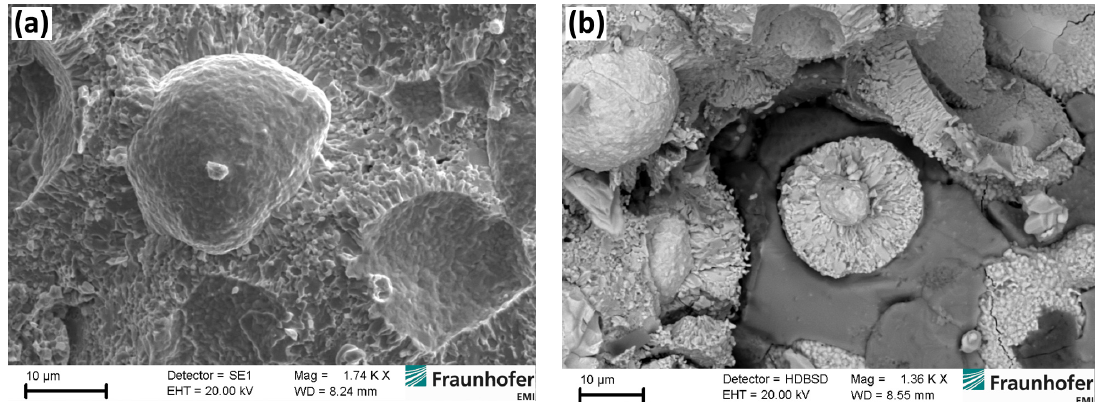
Figure 8. Dissolution of tungsten particles at a fracture surface of a tensile test specimen due to heat